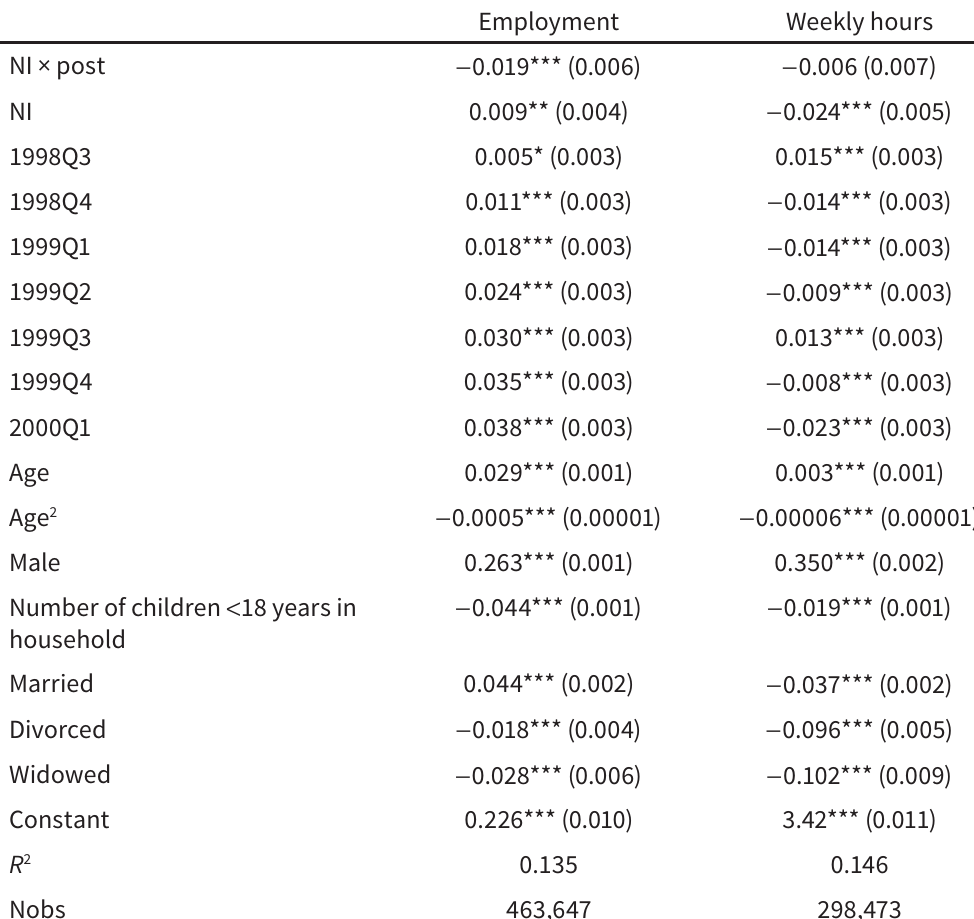
Full difference-in-differences estimates of impacts of the NMW introduction on employment and hours in NI, coefficients (standard errors)